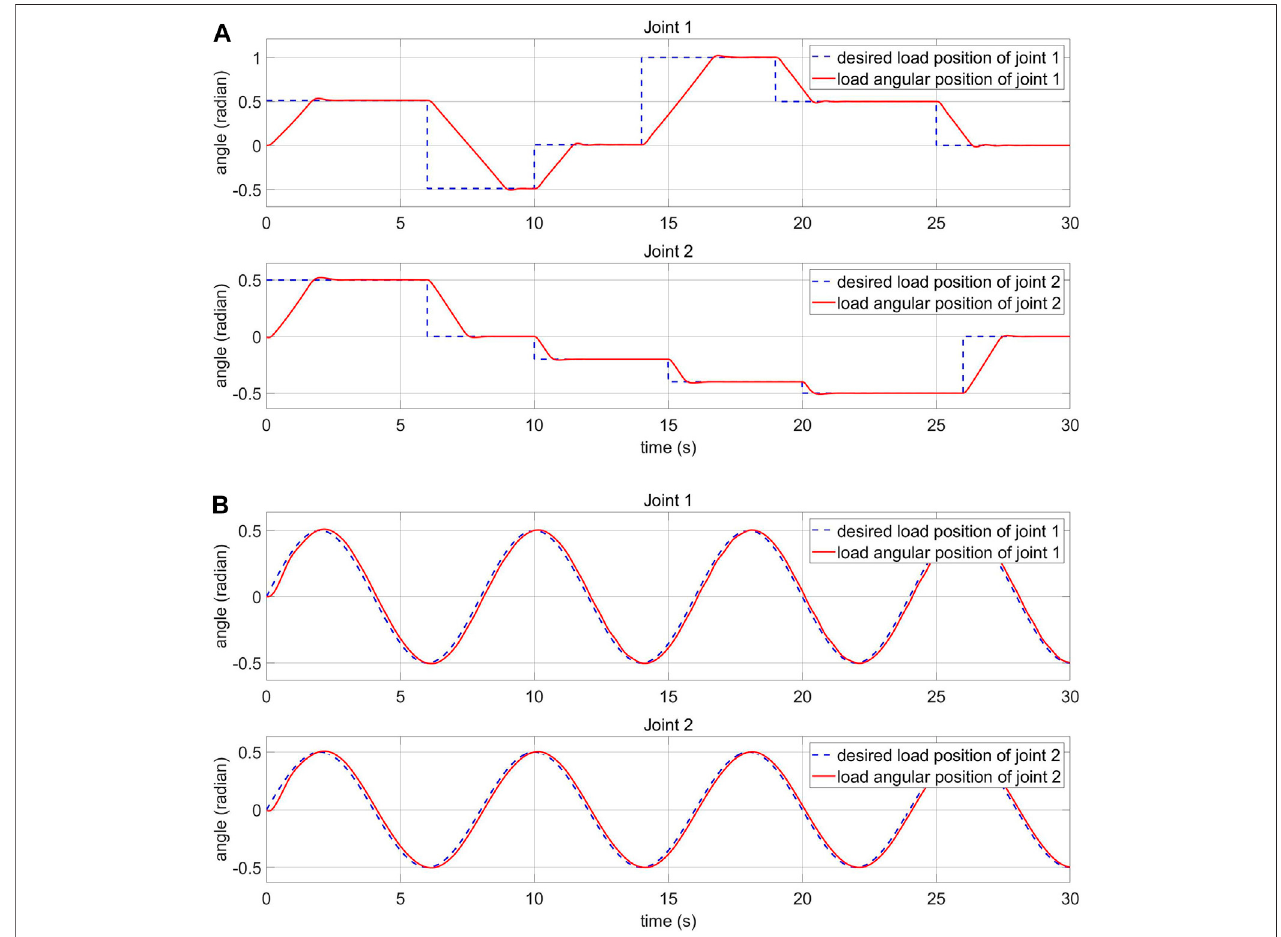
FIGURE 10 | Load-side response of the FPIC-MRAC (A) step input (B) sine input.